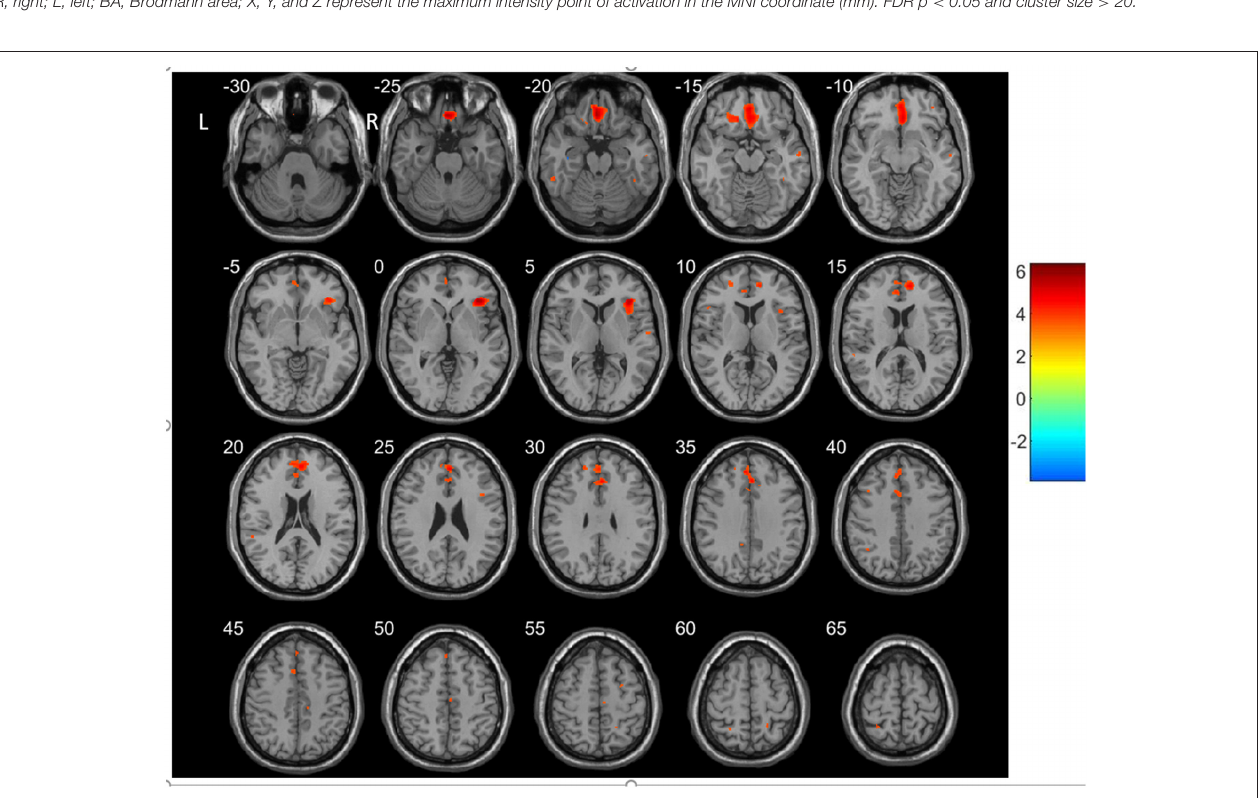
FIGURE 2 | Regions showing decreased gray matter volumes (GMVs) in patients with SCH compared to the controls ( p < 0.05, FDP-corrected). R, Right; L,